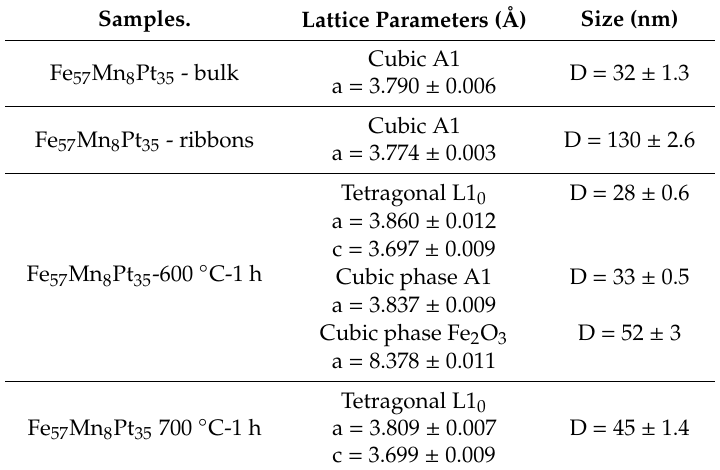
Table 2. X-ray diagrams fitting results for the sample Fe 57 Mn 8 Pt 35